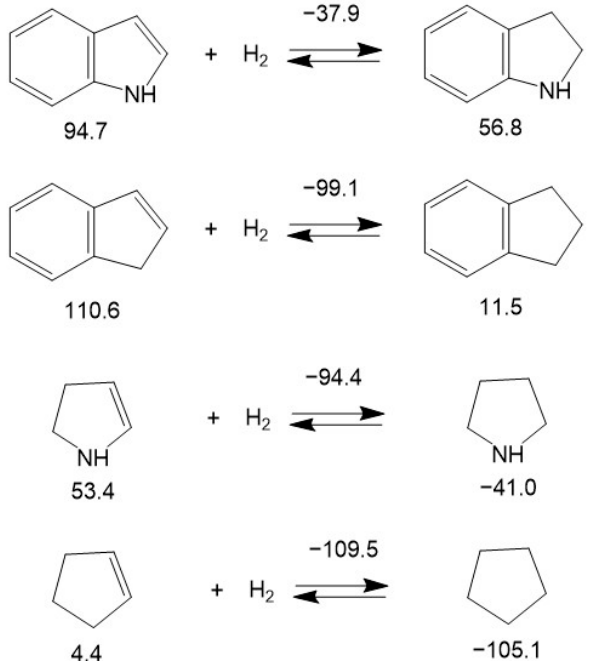
Figure 7. Comparison of the energetics of hydrogenation of double bonds in nitrogen-containing five-membered rings (indole and 2-pyroline) and in the corresponding carbocyclic aromatic compounds (indene and cyclopentene). Figures below molecules are ∆ f H o m (liq) taken from Table S2. Figures above the arrows are ∆ r H o m (liq) calculated according to Equation (1). All values are in kJ·mol − 1 .